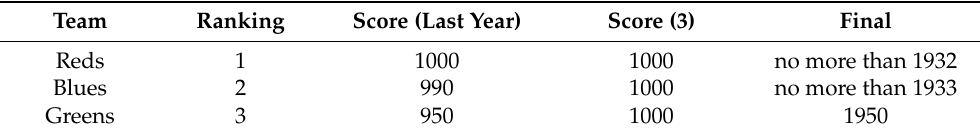
Table 2. Automatic exchange of